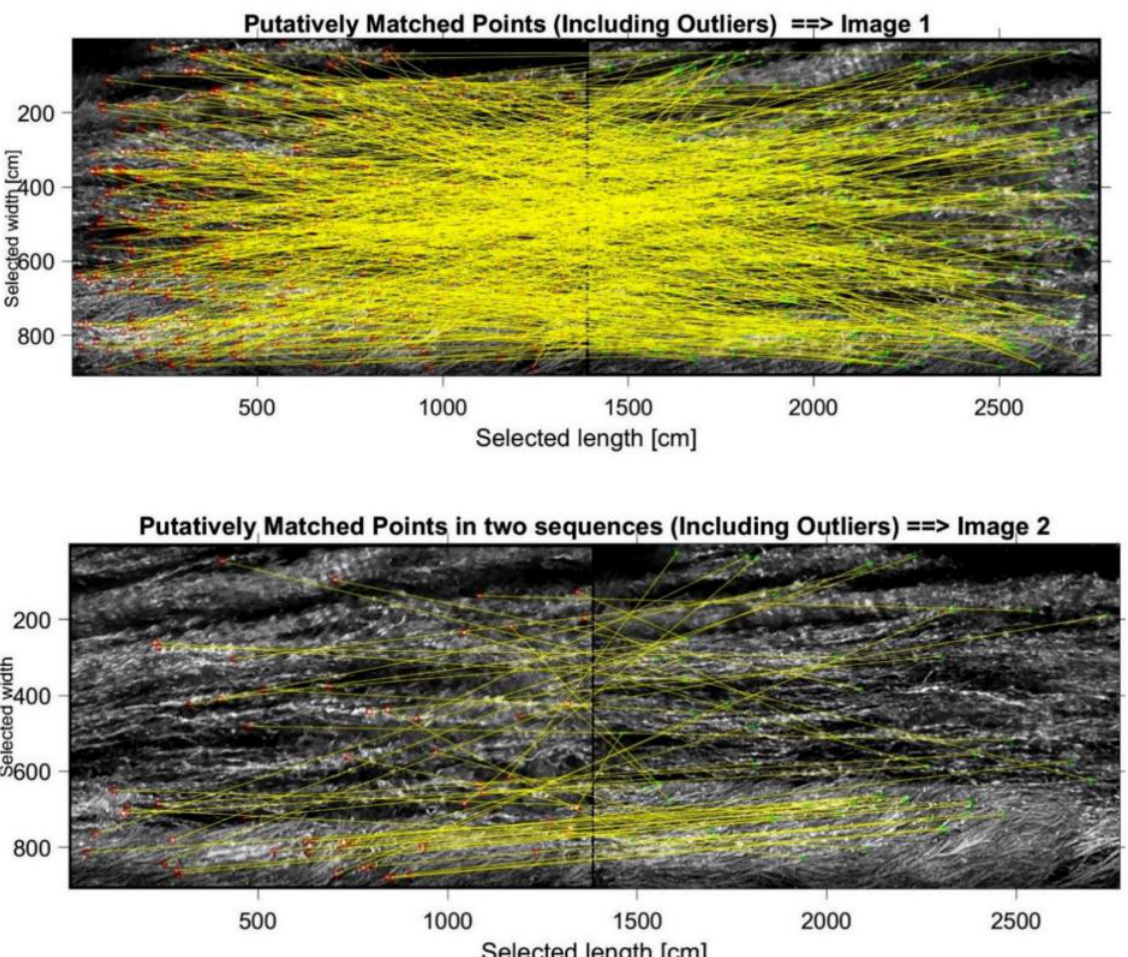
Figure 12. Retrieved points assumed to match the regions of interest in images 1 ( top ) and 2 ( bottom